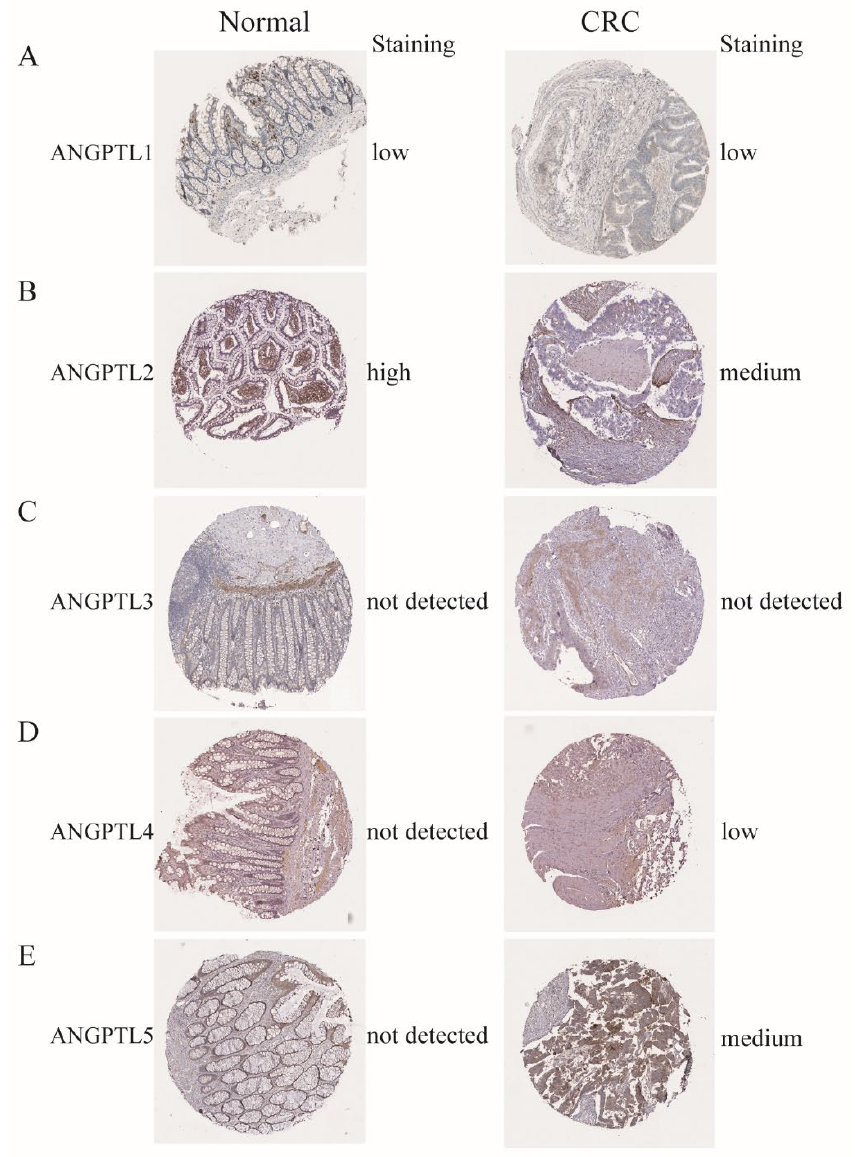
Figure 2. Representative immunohistochemistry images of ANGPTLs in patients with colorectal cancer (The Human Protein Atlas). ( A – E ) The protein expression profiles of five ANGPTLs in normal tissues and colorectal cancer tissues.